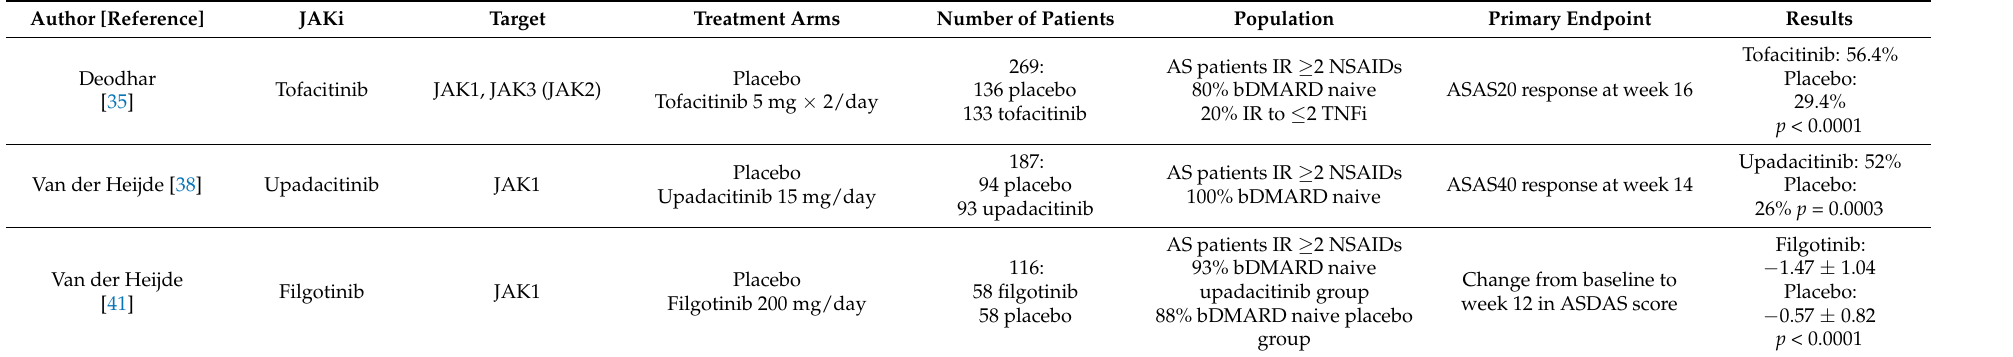
Table 1. Summary of pivotal trials of Janus kinase inhibitors in axial